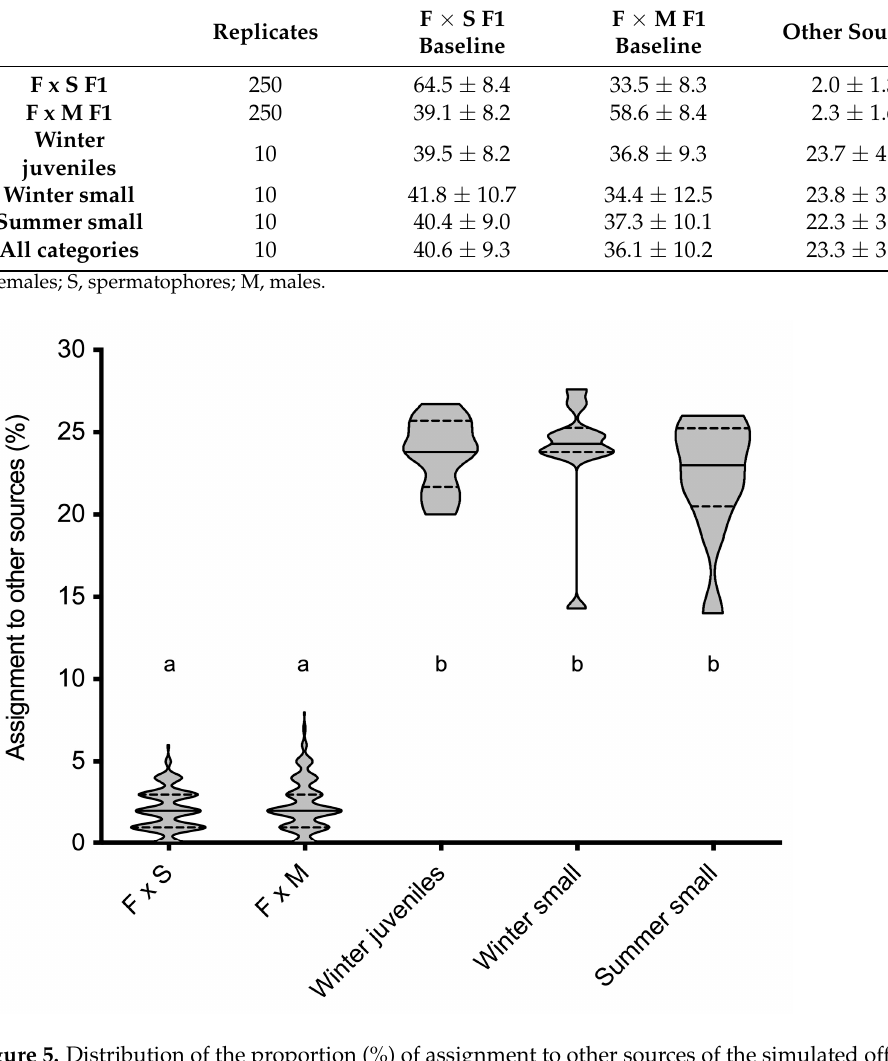
Figure 5. Distribution of the proportion (%) of assignment to other sources of the simulated offspring sets and the 2016 A. antennatus female groups. Continuous lines indicate the median value of each group and dashed lines represent the quartiles. Letters (a, b) indicate groups identified by the post-hoc Scheffe test. F, females; S, spermatophores; M, males.